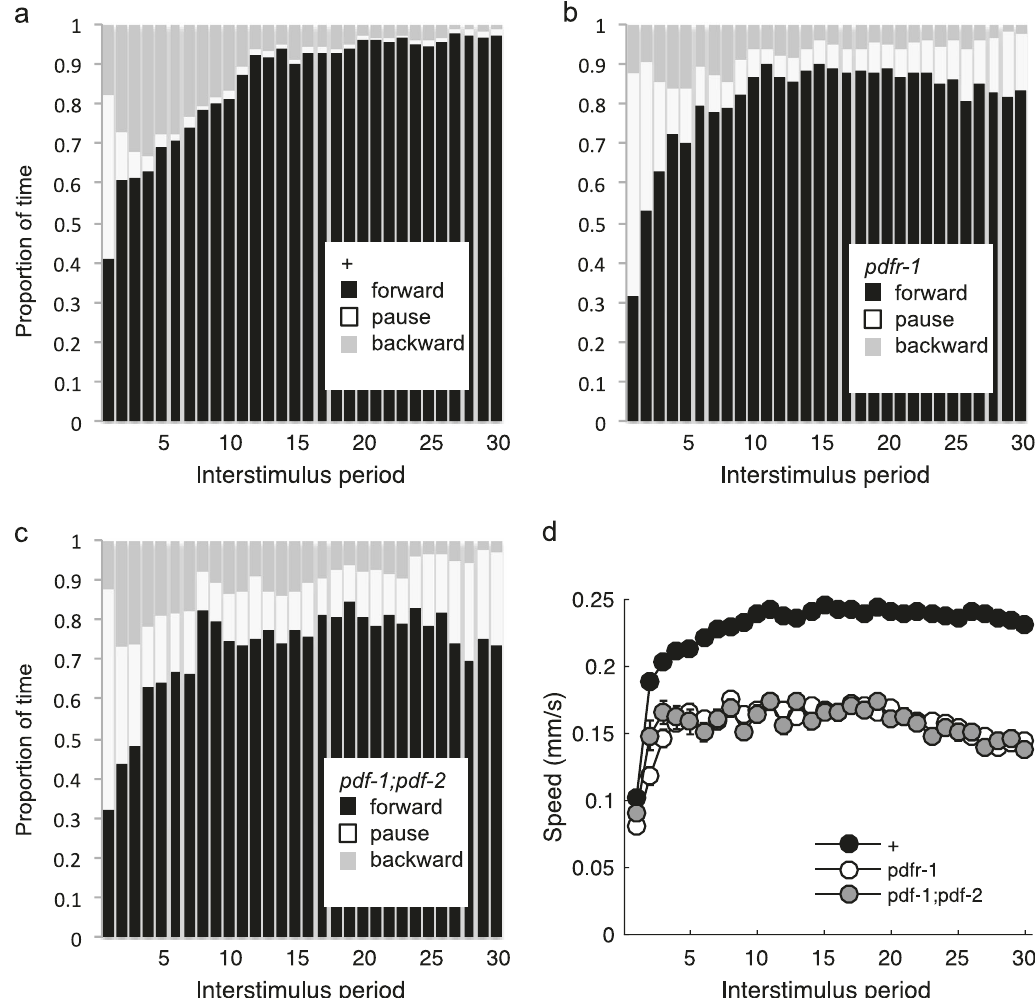
Fig. 6 Shift in locomotion between stimuli. Proportion of the population ’ s time spent moving forward, backward, or not at all during the 3 s interval immediately preceding each stimulus delivered at 0.1 Hz for control ( a ) and pdfr-1 ( b ) and pdf-;pdf-2 ( c ) mutants. d Speed of worms moving forward during the same 3 s intervals. Mean ± SEM. N = 6